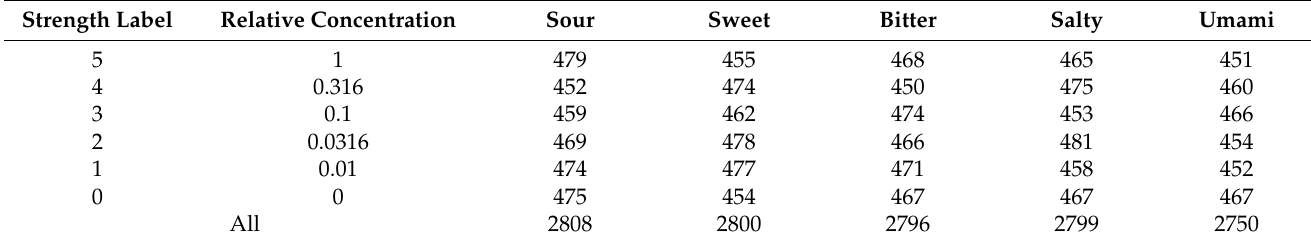
Table 3. Number of samples in datasets for different taste types.